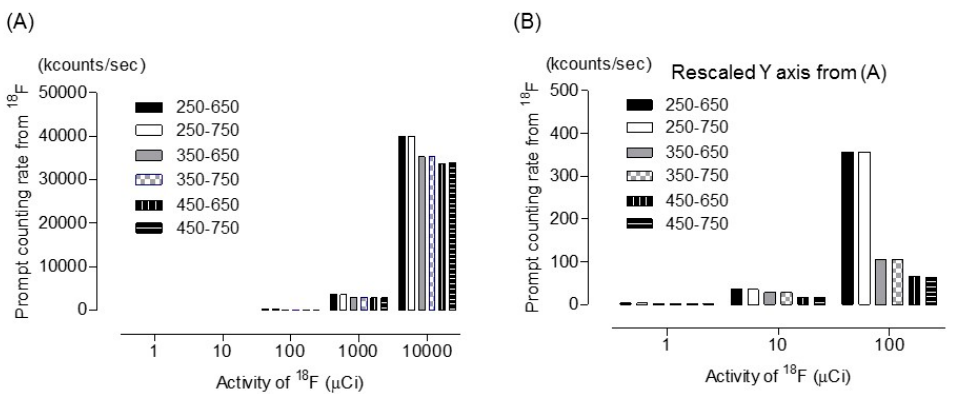
Figure 3. ( A ) Prompt emission counting rate due to 18 F within various energy windows. ( B ) Rescaled Y axis from Figure 3A. Activities were set to 1, 10, 100, 100, 10,000 µCi. Table 1. 131 I prompt emission fraction with various energy windows and